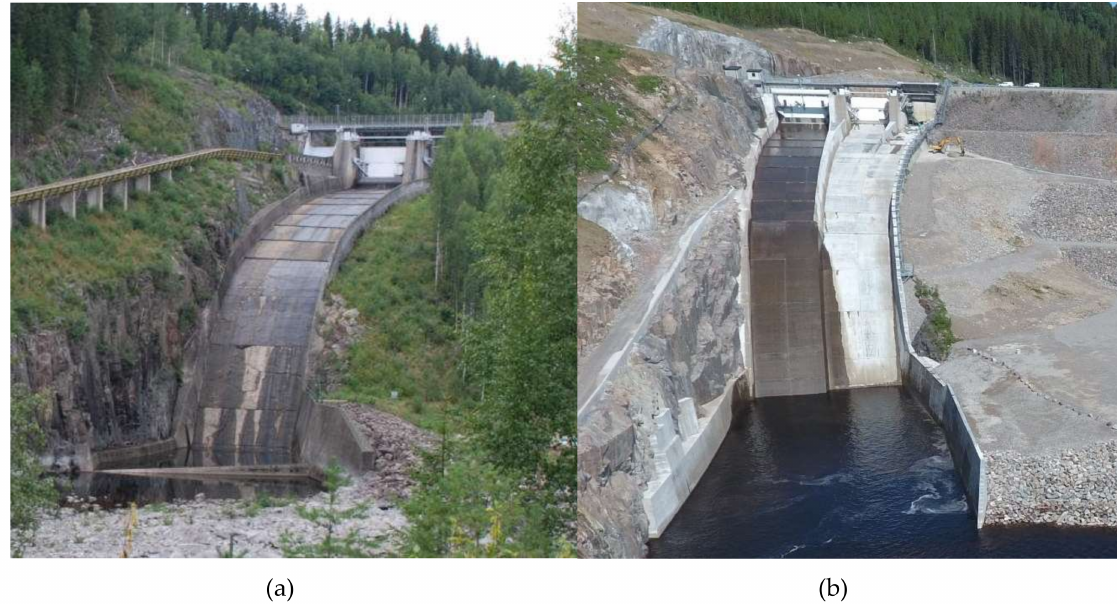
Figure 3. Höljes dam spillway: ( a ) Original layout with two gated openings and a timber flume (© Fortum Generation AB); ( b ) After refurbishment, with a 17 m new gated opening added adjacent to the existing ones (© Hydro Terra